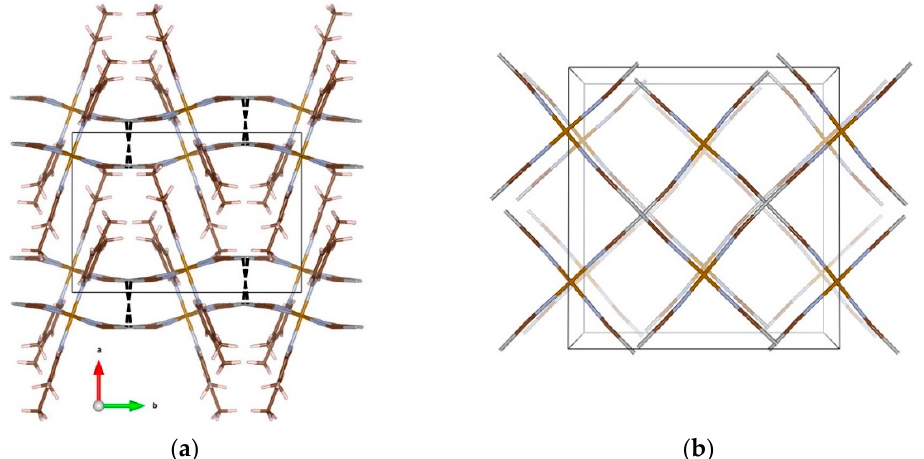
Figure 2. View of the relative disposition of the layers of Fe(3,4-dimethyl-pyridine) 2 [Ag(CN) 2 ] 2 . ( a )